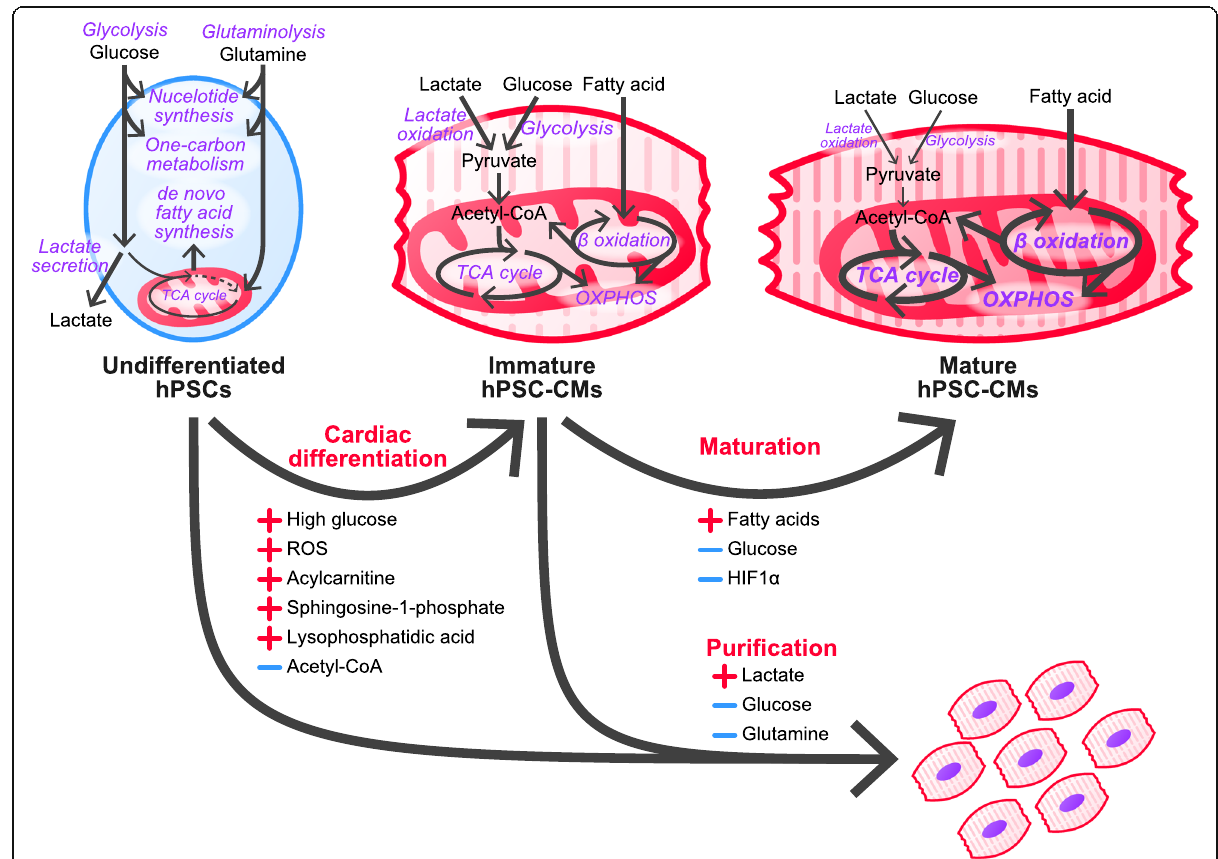
Fig. 2 Metabolic regulation of hPSC cardiac differentiation and maturation. Undifferentiated hPSCs upregulate glycolysis, glutaminolysis, nucleotide synthesis, one-carbon metabolism, de novo fatty acid synthesis. Cardiac differentiation is enhanced by high glucose, ROS, fatty acylcarnitine, sphingosine-1-phosphate, and lysophosphatidic acid. On the other hand, glucose-derived acetyl-CoA inhibits differentiation. hPSC- CMs are metabolically immature and rely on lactate oxidation and glycolysis. By growing hPSC-CMs with fatty acids in the absence of glucose, hPSC-CMs metabolically mature and activate β oxidation and OXPHOS. Activation of HIF1 α inhibits maturation. hPSC-CMs can be purified by utilizing the metabolic features of undifferentiated hPSCs and hPSC-CMs. Glucose- and glutamine-deprived, lactate-supplemented medium can purify hPSCs and eliminate undifferentiated hPSCs and non-cardiomyocytes. OXPHOS, oxidative